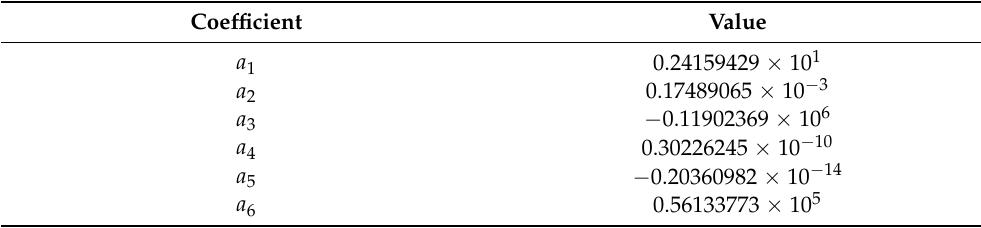
Table 1. Nitrogen coefficients of the polynomial for the determination of ideal gas enthalpy [55].